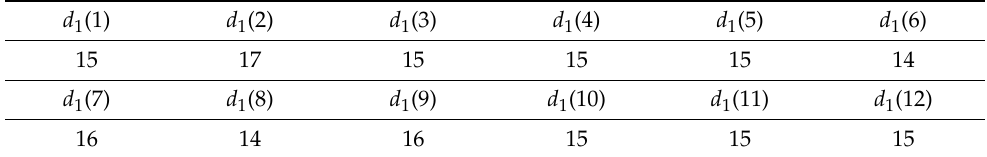
Table 1. Average demand 1.